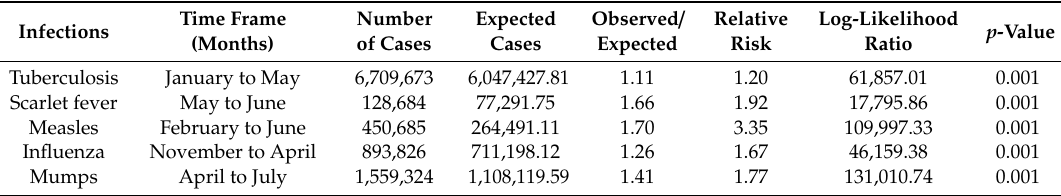
Table 2. The temporal clusters of reportable RIDs (2006–2016) in